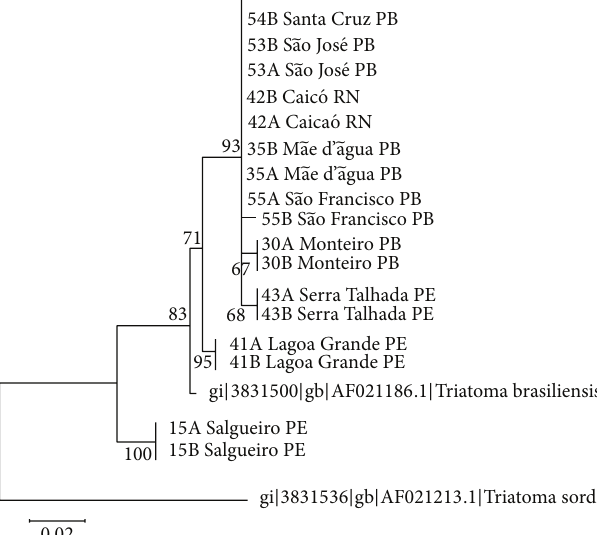
Figure 2: Maximum Likelihood phylogeny generated from CO1 sequences using the Kimura-2-parameter model with 1000 bootstrap replicates. Sequences were rooted with T. sordida (GenBank acc. no.: AF021213).